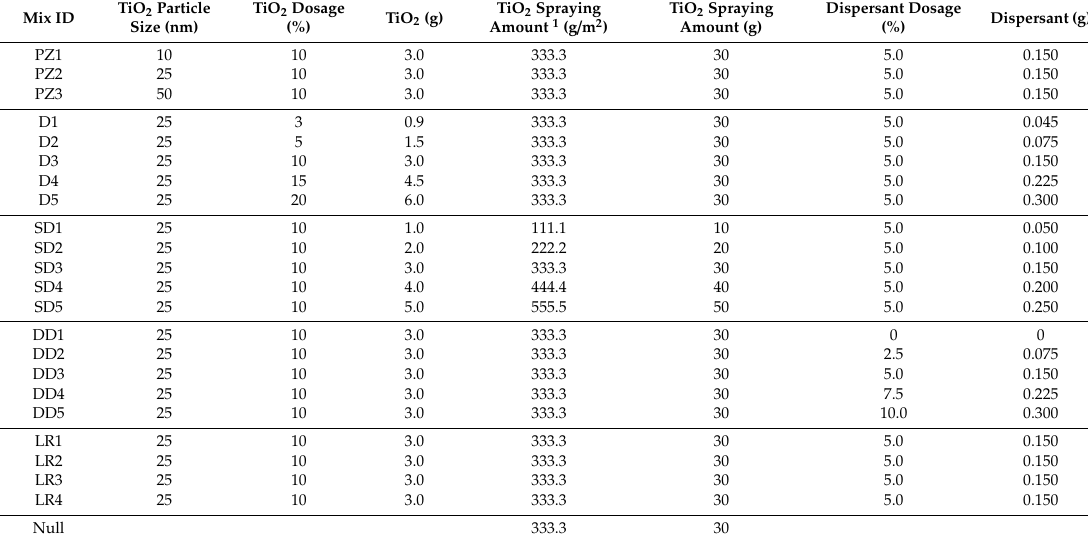
Table 2. Mixing ratio of photocatalytic coating.